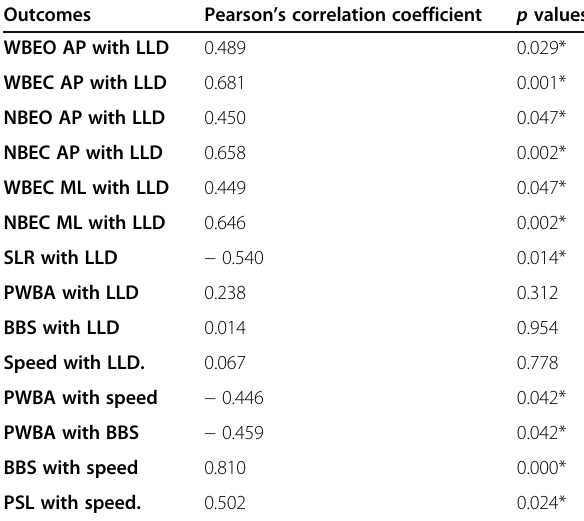
Table 3 Depicts association between LLD, balance, and gait outcome